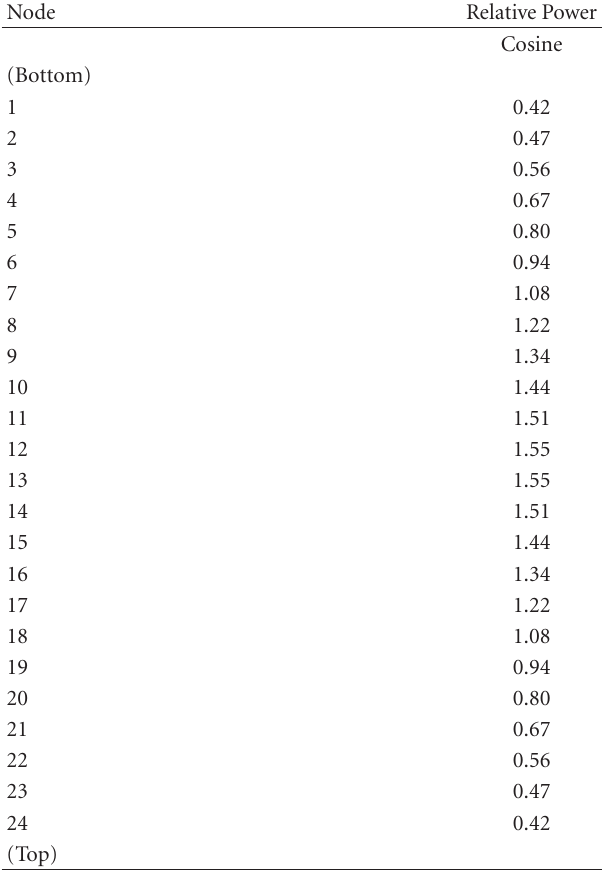
Table 4: Cosine power profile